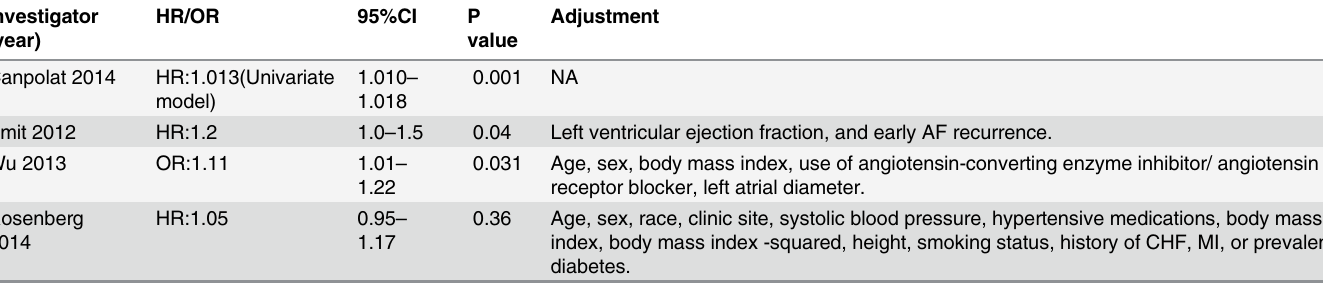
Table 3. Confounding factors used in multivariate